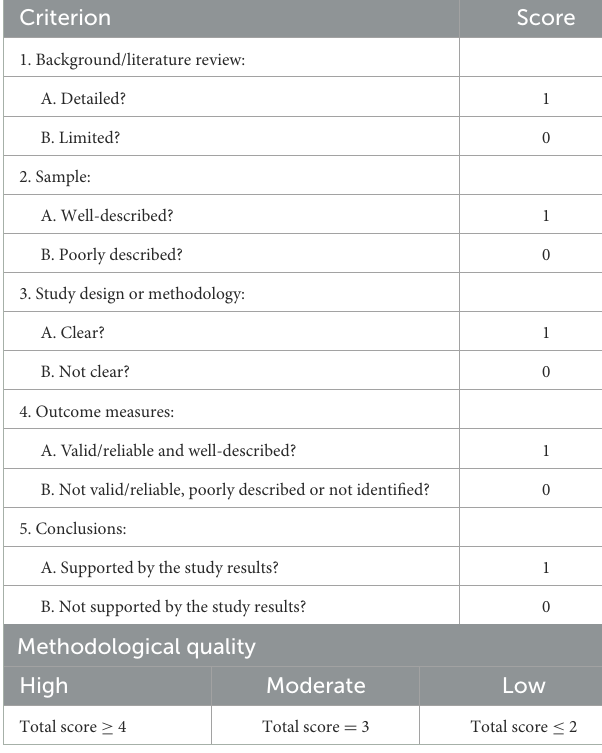
TABLE 1 Methodological quality assessment tool. Criterion